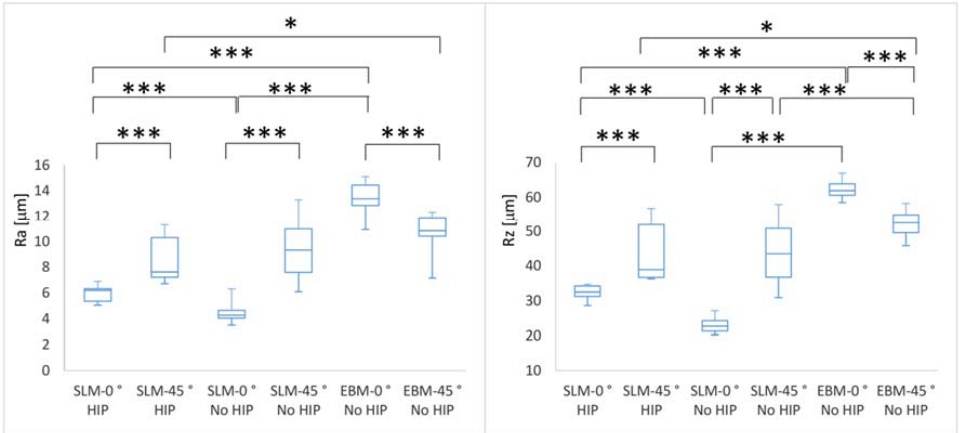
Figure 12. Box plots of the measured R a and R z values for the SLM- and EBM-manufactured parts. Box plots give the median value, the interquartile range (IQR: interval between the 25th and 75th percentile, blue rectangle) and the extremum values ( n = 4 struts); statistical significance levels (* p < 0.05; *** p < 0.001).